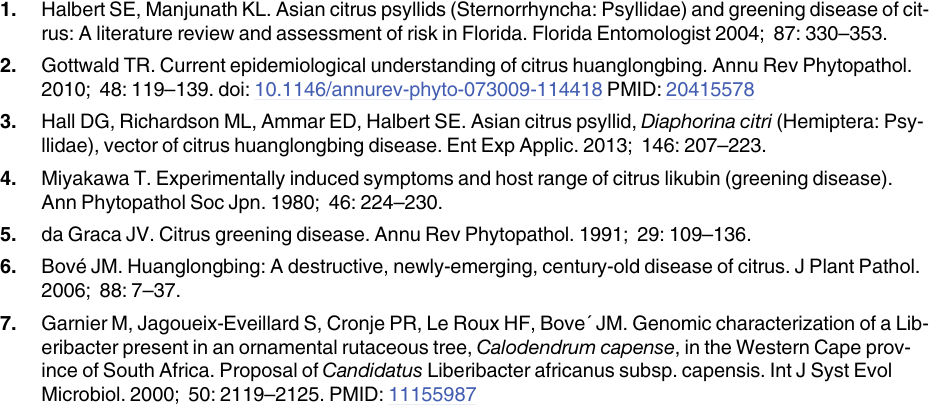
S2 Table. Results of regression analyses on Ct values in qPCR tests of D . citri that fed on Las-infected plants as nymphs or adults for an acquisition access period (AAP) of 1, 7 or 14 days. S3 Table. Las replication in D . citri following acquisition as nymphs: Multiple comparisons of post-acquisition differences in Las titer (relative to RPS20 psyllid gene) between 1 and 35 days post-first access to diseased plants (padp) in D . citri that were exposed as nymphs to Las-infected plants for 1- or 7-day acquisition access period (AAP). S4 Table. Las replication in D . citri following acquisition as adults: Multiple comparisons of post-acquisition differences in Las titer (relative to RPS20 psyllid gene) between 1 and 42 days post-first access to diseased plants (padp) in D . citri that were exposed as adults to Las-infected plants for 1-, 7- or 14-day acquisition access period